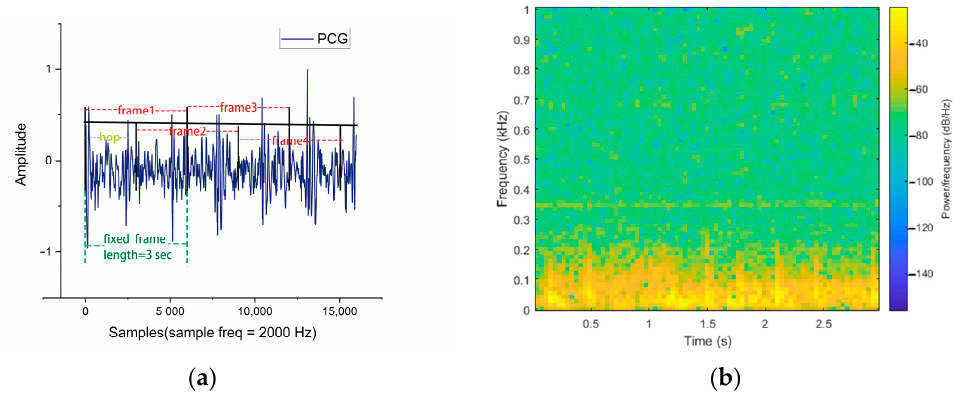
Figure 3. Segmentation of the heart sound signal and a time-frequency diagram of a 3 s segment. ( a ) Asynchronous segmentation example with a length of 3 s where the hop size was 1.5 s. ( b ) Time-frequency diagram of the heart sound signal of 3 s.